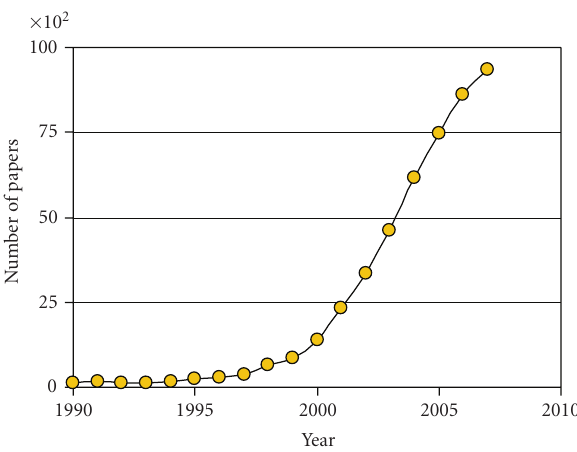
Figure 2: Graph of the amount of papers containing the keyword “microfluidic” that were published per year as determined with Google Scholar. A more than 30-fold increase in the yearly number of scientific publications with this particular keyword can be observed in the decade between 1995 and